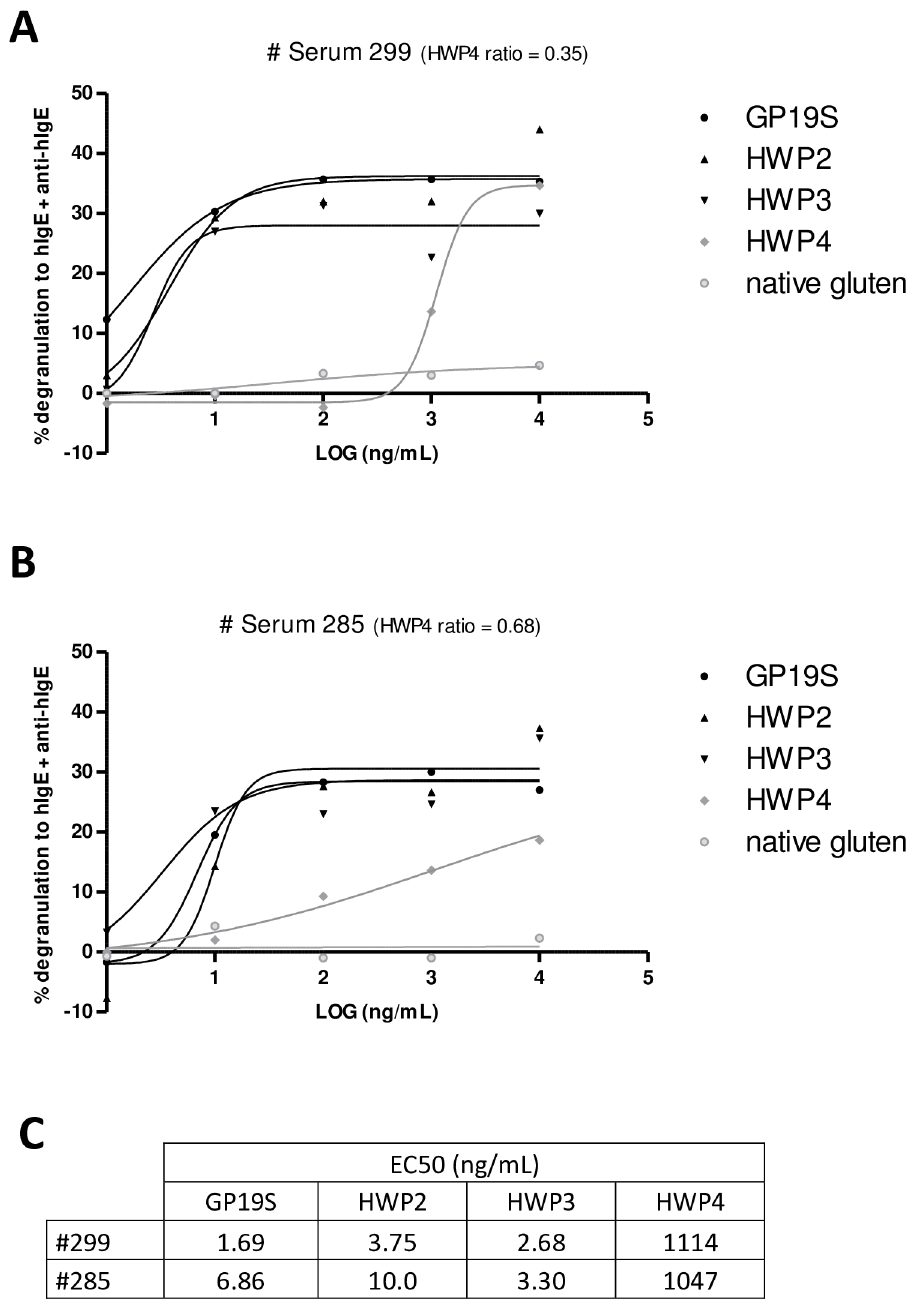
Fig 2. Degranulation induced by different HWPs of RBL-SX38 cells sensitized with sera from 2 HWP- allergic patients. Human Fc ε RI-expressingRBL cells were passivelysensitizedwith serum #299 (A) or with serum #285 (B) and subsequently activated with anti-human IgE antibody or five concentrations (1 ng/mL to 10 μ g/mL) of native gluten, HWP2, 3, 4 or GP19S. The results are expressedas percentages of degranulation comparedto anti-human IgE-induceddegranulation. Symbols represent means of triplicates. EC 50 values were determinedusing GraphPad Prism 5.02for Industrial HWPs (C). HWP, hydrolyzedwheat protein. GP19S, Glupearl19S ®